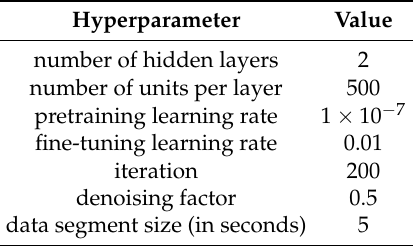
Table 6. Optimal hyperparameters for neural network.